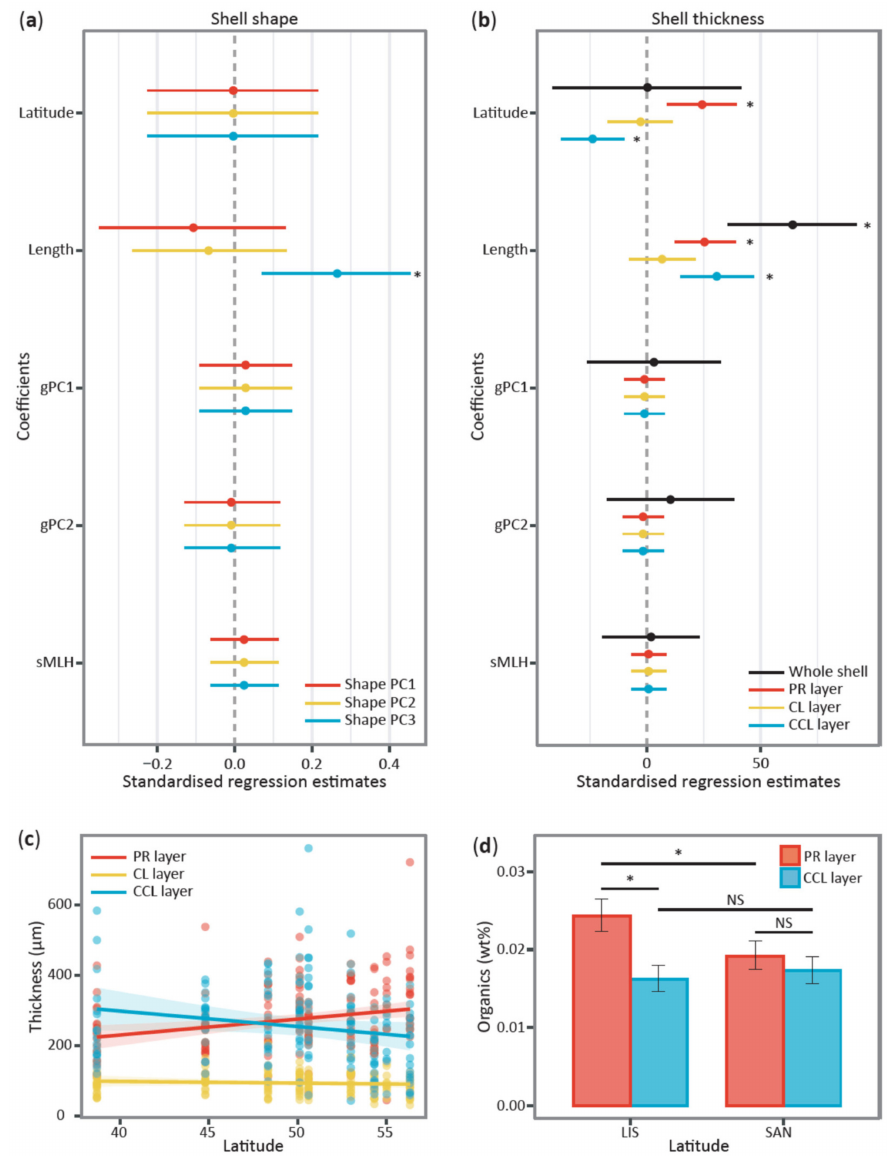
Figure 5. Summary of models of shell shape, thickness and organic content. Panels ( a ) and ( b ) show the mean e ff ect sizes and bootstrapped 95% confidence intervals (CIs) of predictor variables estimated from generalized linear mixed models (GLMMs) of shell shape and shell thickness respectively. Results are summarized in panel ( a ) separately for each of three shape principal components (PCs), which are respectively color-coded in red, yellow and blue respectively. Panel ( b ) summarizes the results of the whole shell thickness model (in black) and the shell layers model, with the granular prismatic (PR) layer shown in red, the crossed-lamellar (CL) layer shown in yellow and the complex crossed-lamellar (CCL) layer shown in blue. Regression parameters were considered statistically significant when the bootstrapped 95% CI (error bars) did not overlap zero (asterisks denote significant di ff erences from zero). ( c ) Relationship between latitude and the thickness of the PR, CL and CCL layers. Mean values (solid lines) and confidence intervals (shaded areas) were predicted while controlling for shell length. ( d ) Latitudinal di ff erences in shell organic content of the PR (red bars) and CCL (blue bars) layers between representative warm temperate (LIS) and cold temperate (SAN) populations. Error bars represent 95% CIs, asterisks represent statistically significant comparisons ( p < 0.05) and NS denotes non-significant